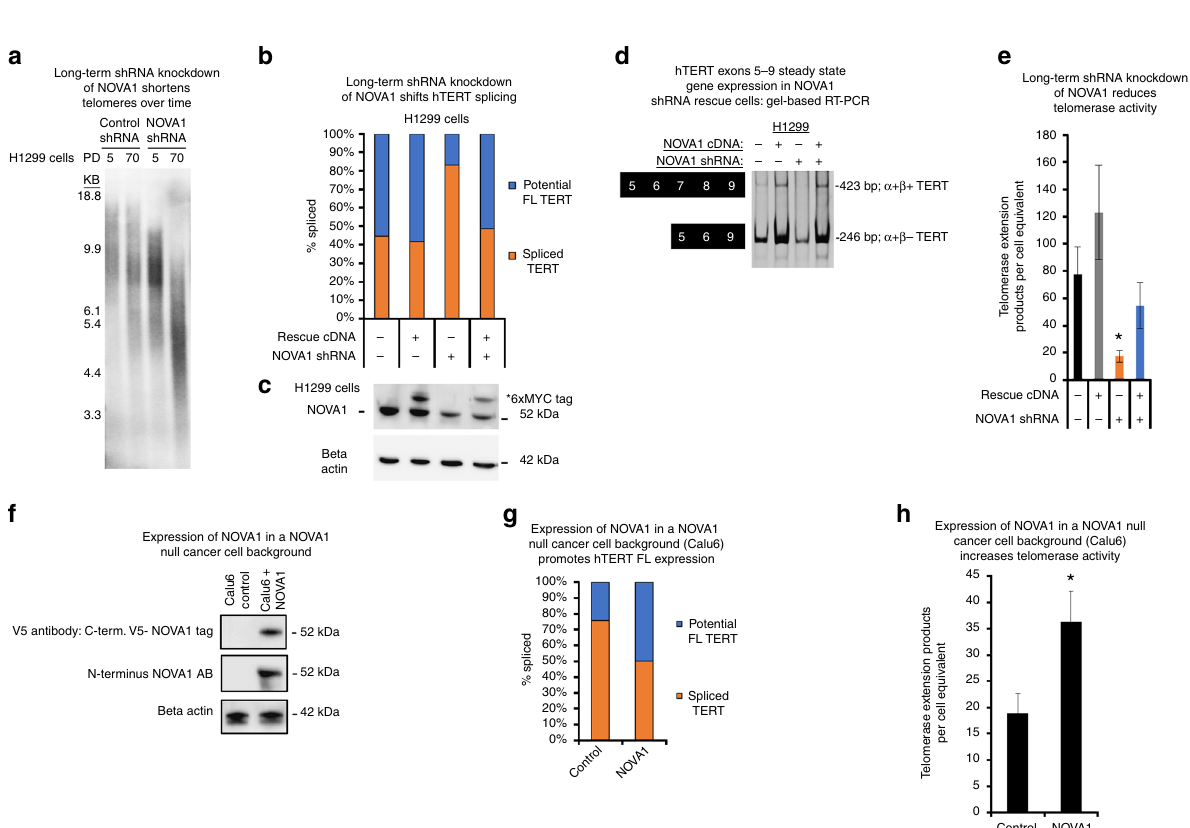
V5 antibody: C-term. V5- NOVA1 tag